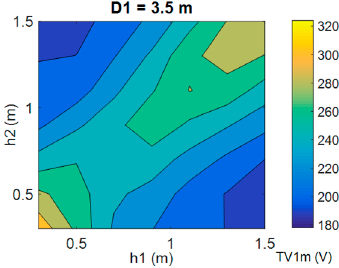
Ω m / 100 Ω m / 2m, D